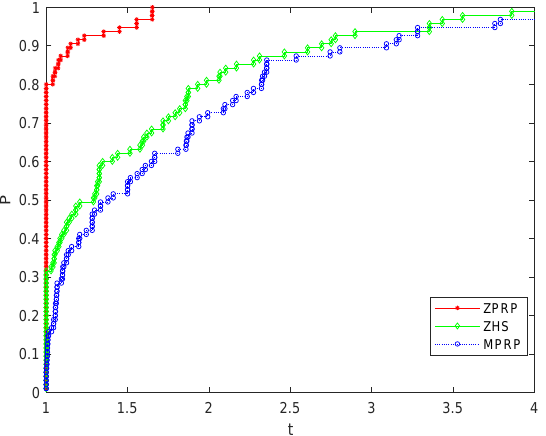
Figure 5. The total number of function and gradient evaluations.